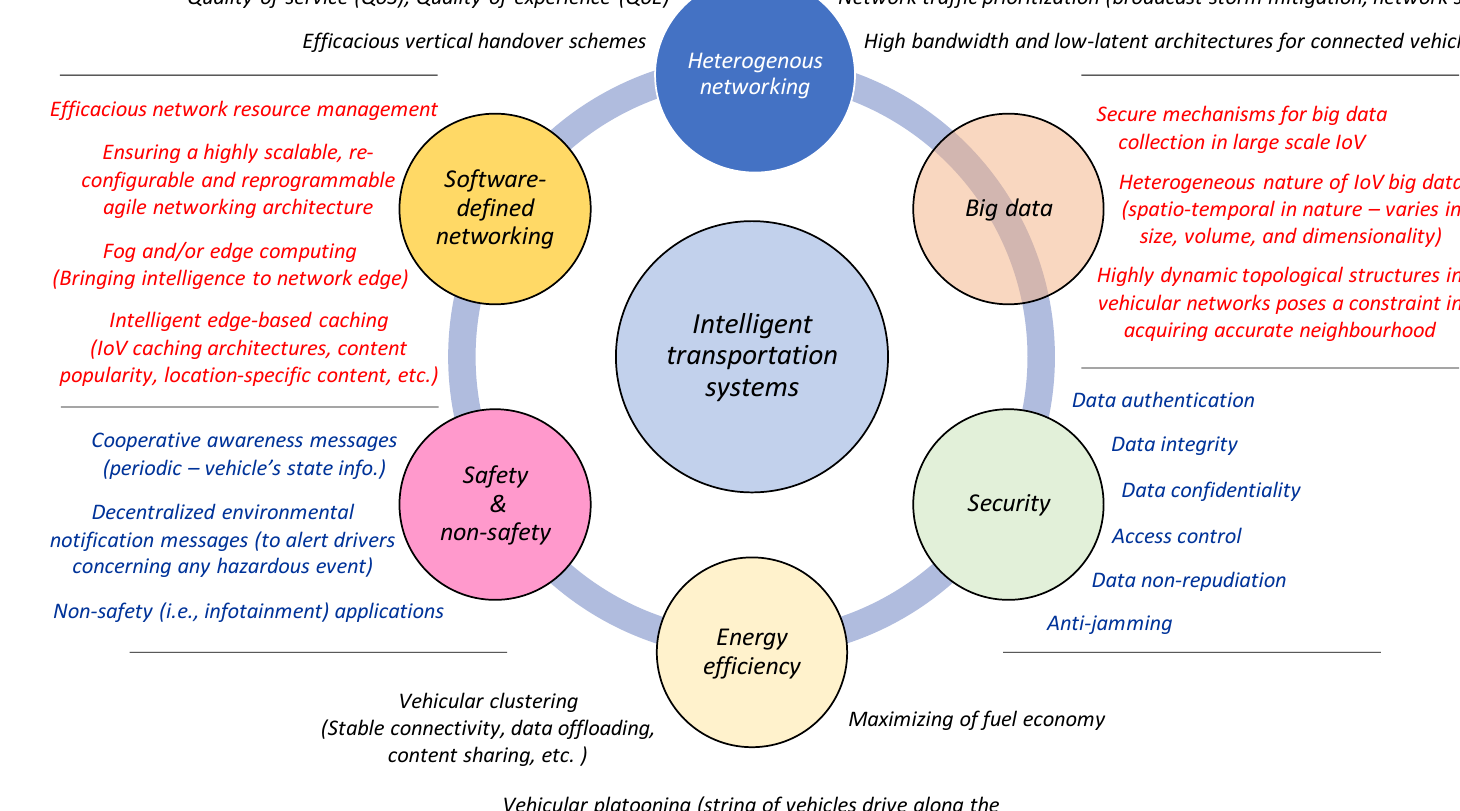
Figure 3. Research challenges surrounding next-generation ITS